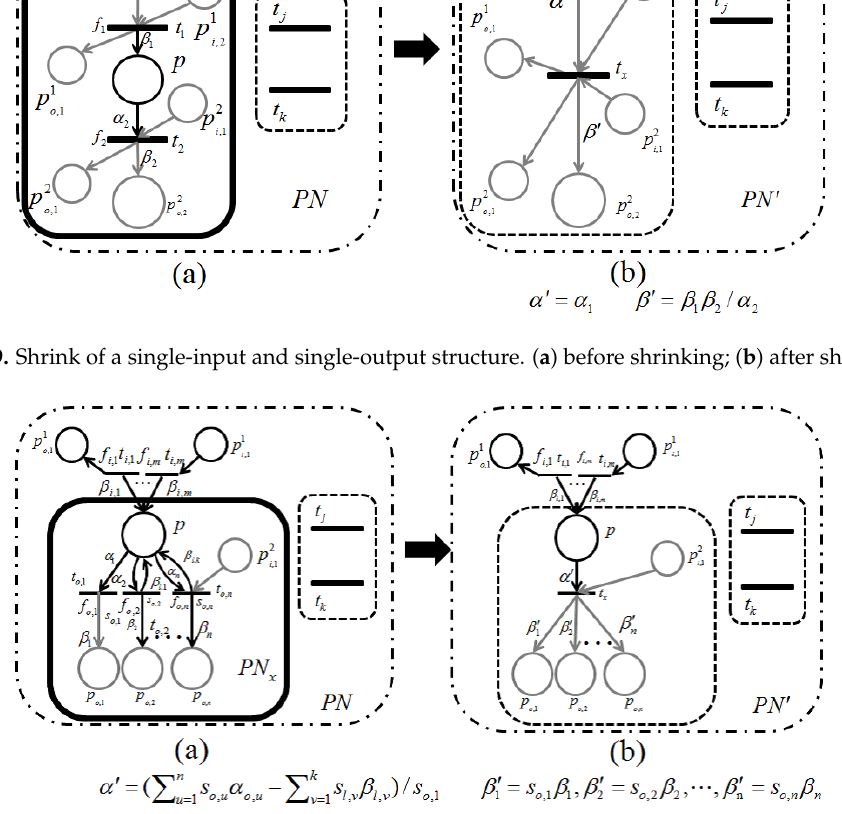
Figure 10. Shrink of a conflict and self-loop structure. ( a ) before shrinking; ( b ) after